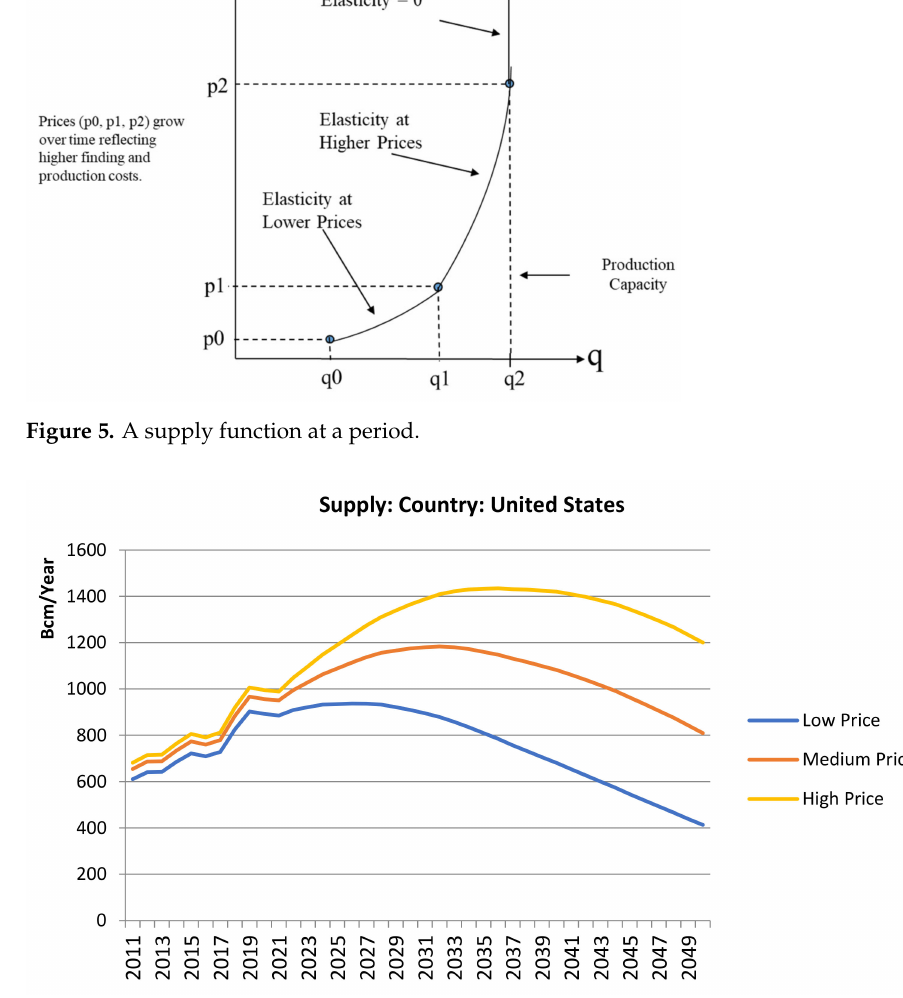
Figure 6. Supply curves under given price scenarios over